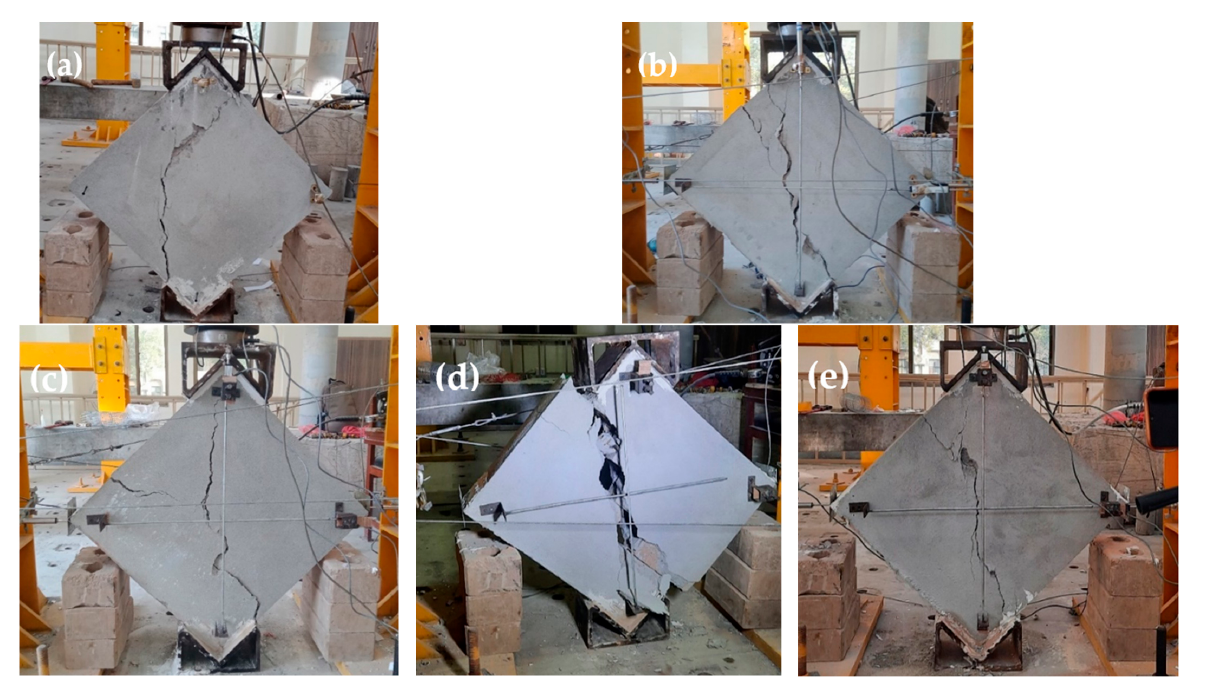
Figure 8. Crack patterns of REF specimens. ( a ) REF (1); ( b ) REF (2); ( c ) REF (3); ( d ) REF (4); ( e ) REF (5).